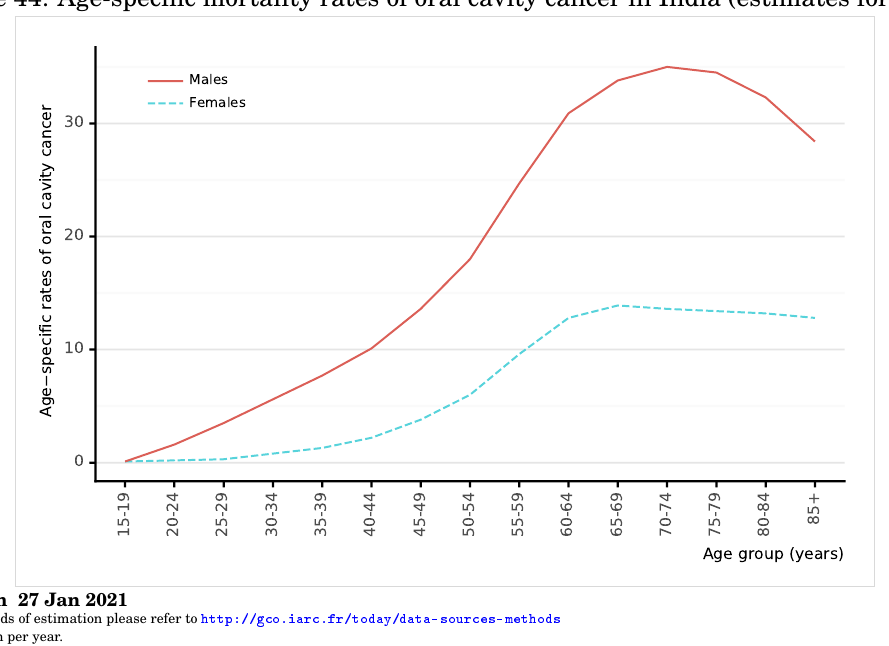
Figure 44: Age-specific mortality rates of oral cavity cancer in India (estimates for 2020)